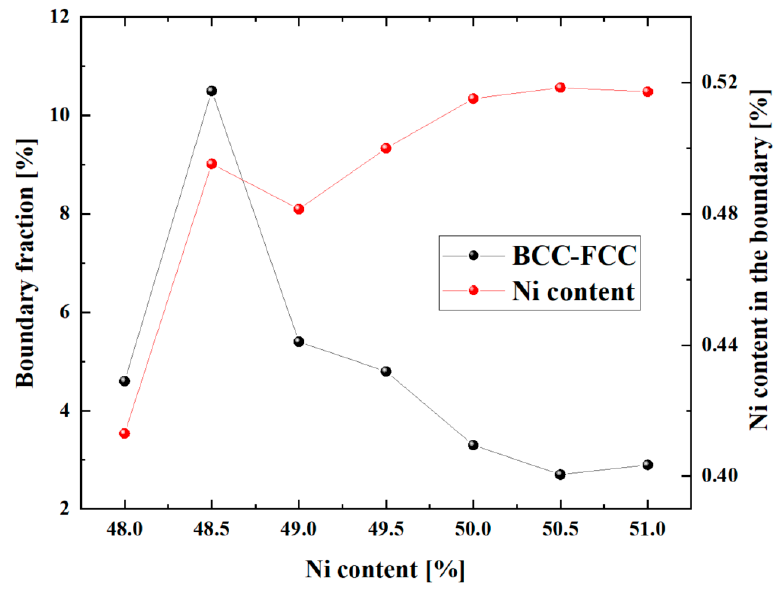
Figure 12. Variation of the BCC-FCC boundary volume fraction and Ni content in the boundary with global Ni content ranges from 48.0% to 51.0% at a temperature of 50 K.